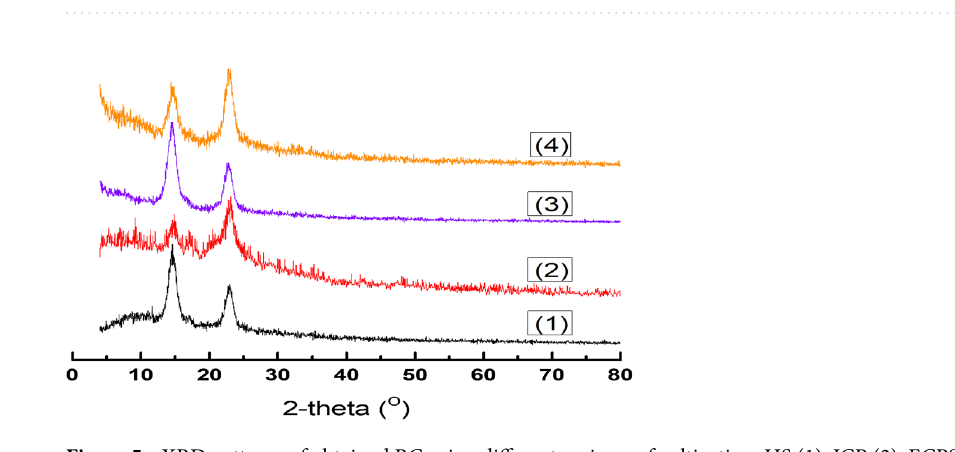
Figure 4. FT-IR spectra of obtained BC membranes using different regimes of cultivation, HS (1), JCP (2), ECPS (3), and EPC (4) media.